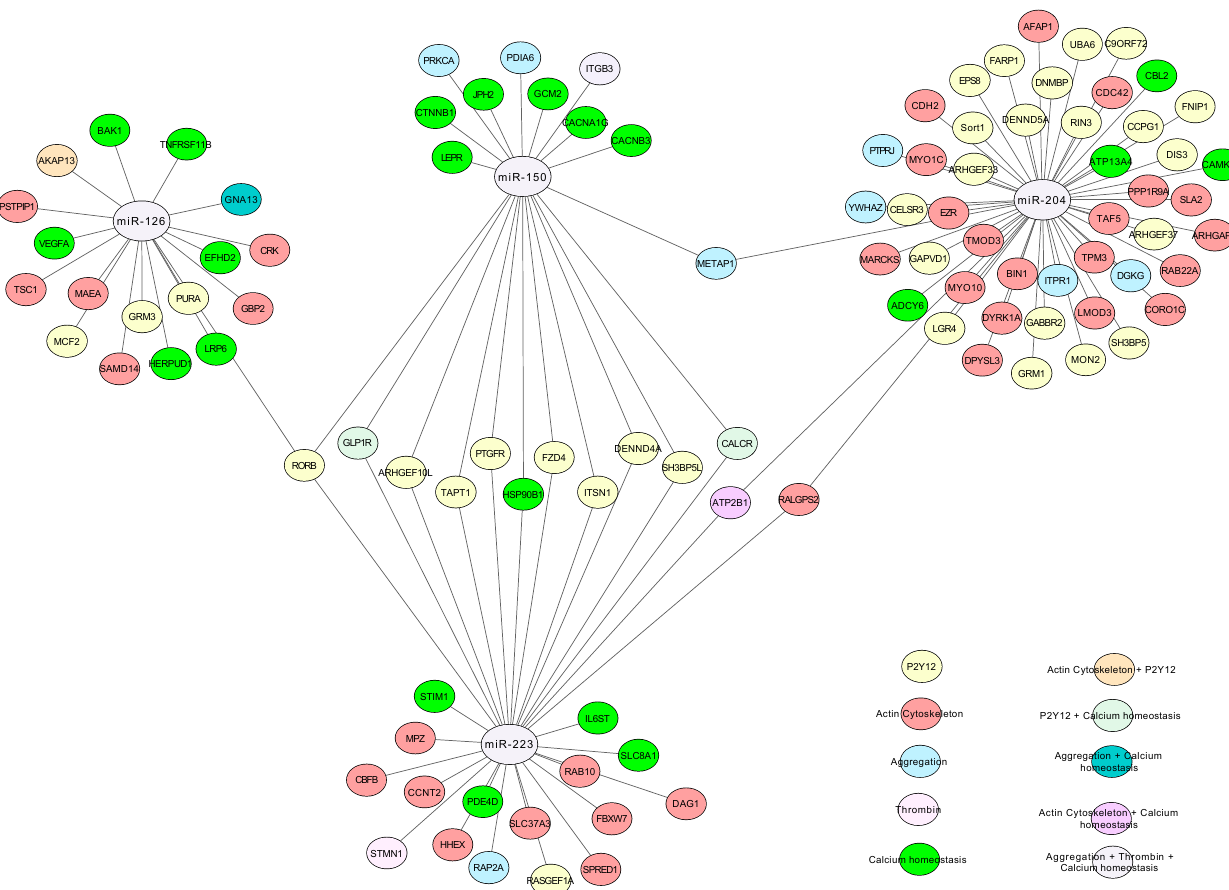
Figure 2. Network of miRNAs predicted targets and their involvement in platelet function-related pathways including aggregation (blue), P2Y12 (yellow), actin cytoskeleton (red), thrombin (pink) and calcium homeostasis (green).